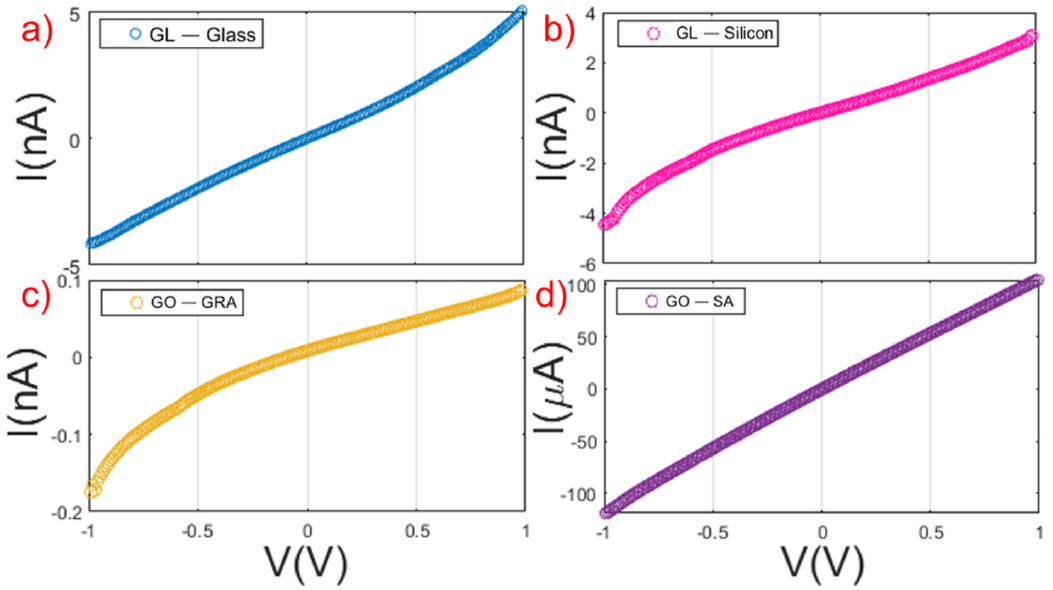
Figure 6. IV characteristics of the four films deposited on different substrates (glass, silicon) in the ±1 V range of the applied bias voltage. Plot ( a ) IV curve of GL film on glass; ( b ) IV curve of GL film on silicon; ( c ) IV curve of GO-GRA film on a glass substrate; ( d ) IV curve of GO-SA film on a glass substrate. Differently from previous preliminary surveys on GL-based films [65,67], a strong nonlinearity of the IV curves has been highlighted, demonstrating that GL films could be used as state-of-the-art detectors based on GRMs with a high performance in terms of